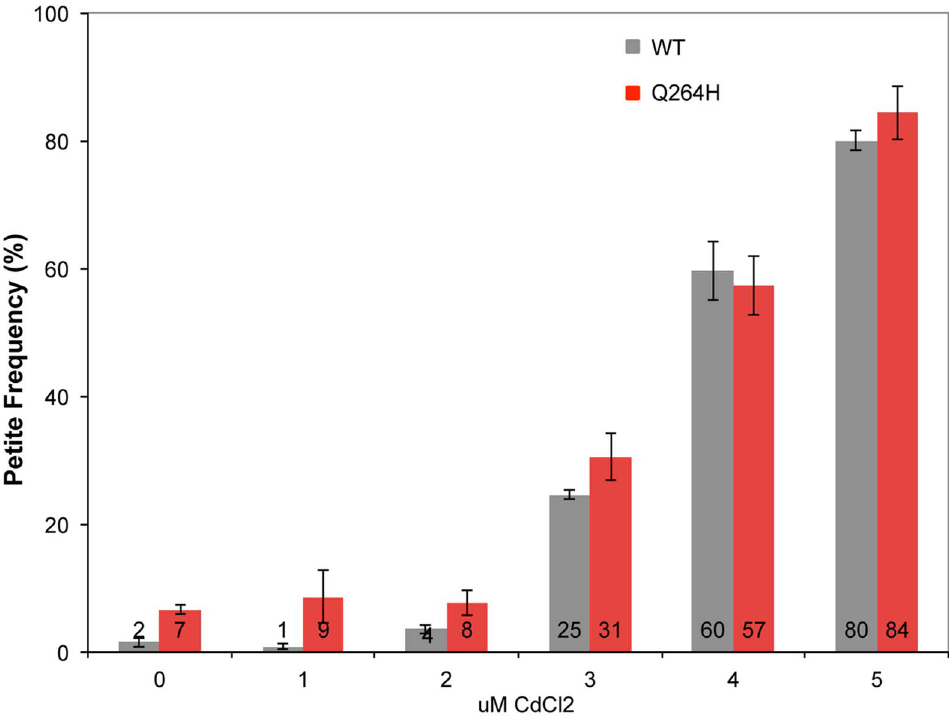
Figure 6. Cadmium chloride increases petite formation and decreases mtDNA replication. Petite colony formation of heteroallelic strains containing a centromeric plasmid encoding MIP1 or mip1 with the mutation encoding the Q264H variant after exposure to different concentrations of cadmium chloride. mtDNA, mitochondrial DNA; nDNA, nuclear DNA.